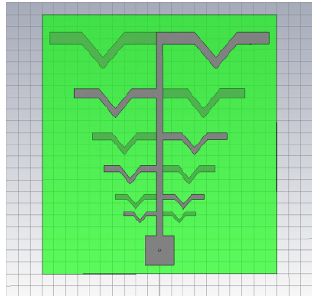
Figure 7. LPKFA with flare angle